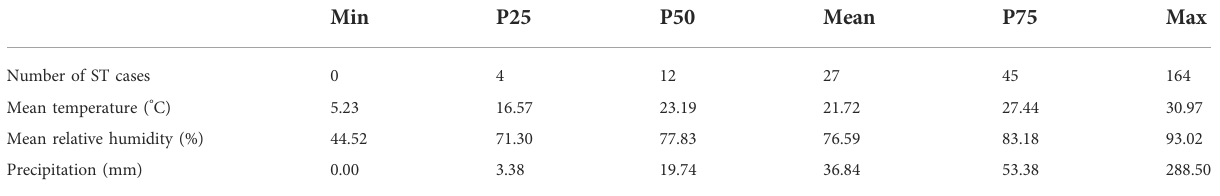
TABLE 1 Summary of weekly ST cases and meteorological variables in Central Guangdong Province in China, 2006 – 2018.